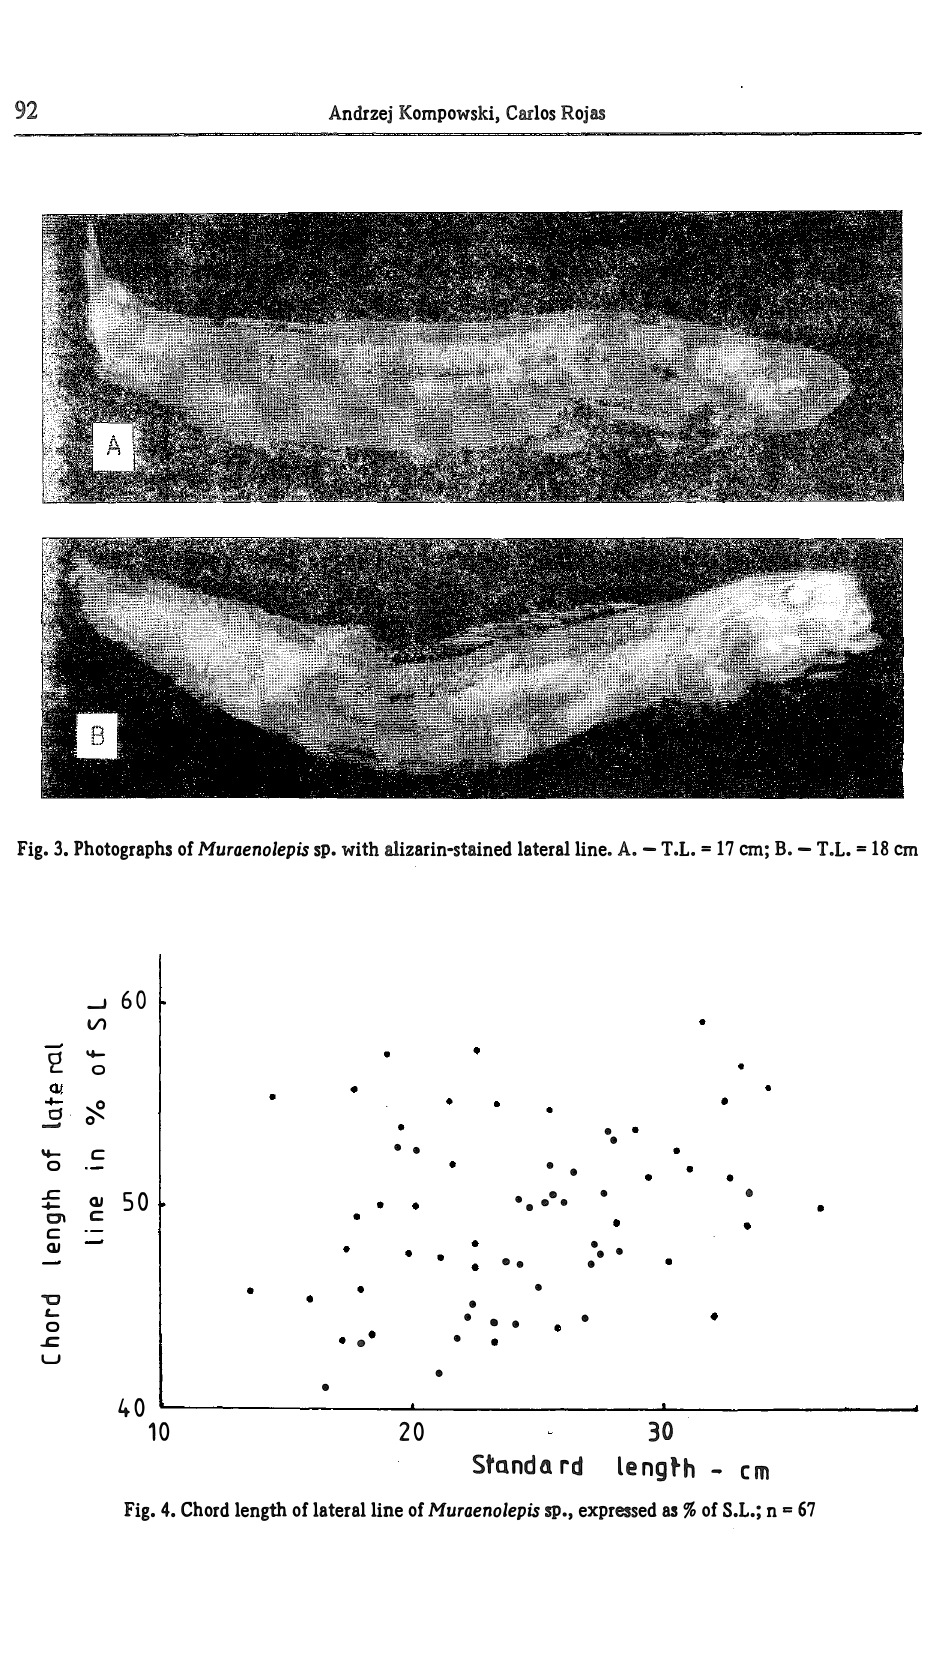
Fig. 4. Chord length of lateral line of Muraenolepis 3Po, expressed a, % of S.L.; n =